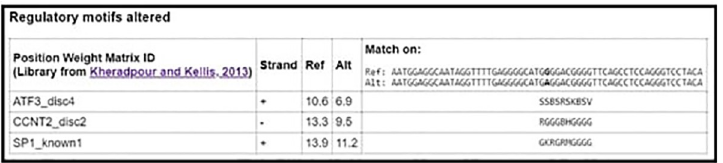
Fig 3. HaploReg v4.1 software predicted an alternation on binding sites of specificity protein 1 (SP1), activating transcription factor 3 (ATF3), and cyclin T2 (CCNT2) transcription factors due to tumor necrosis factor (TNF)- α -308 G/A gene polymorphism (rs1800629).